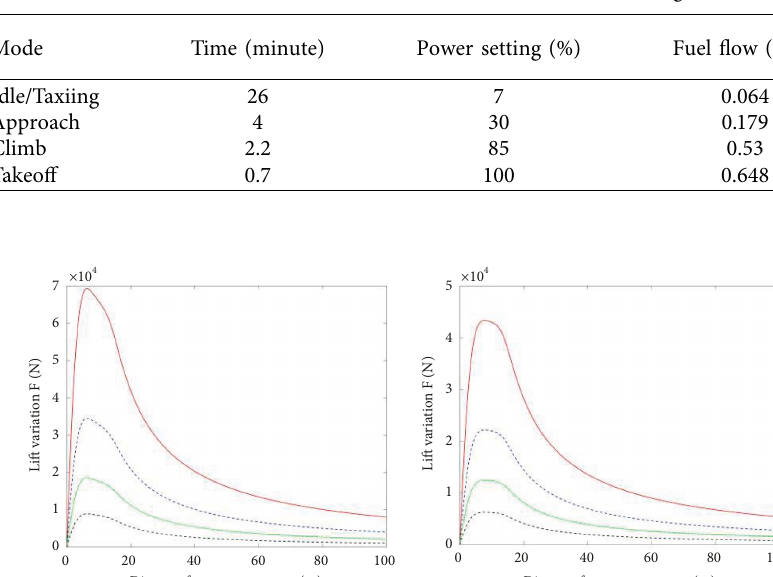
Table 4: Emission data for CF34-8C5 engine at international (ISA).